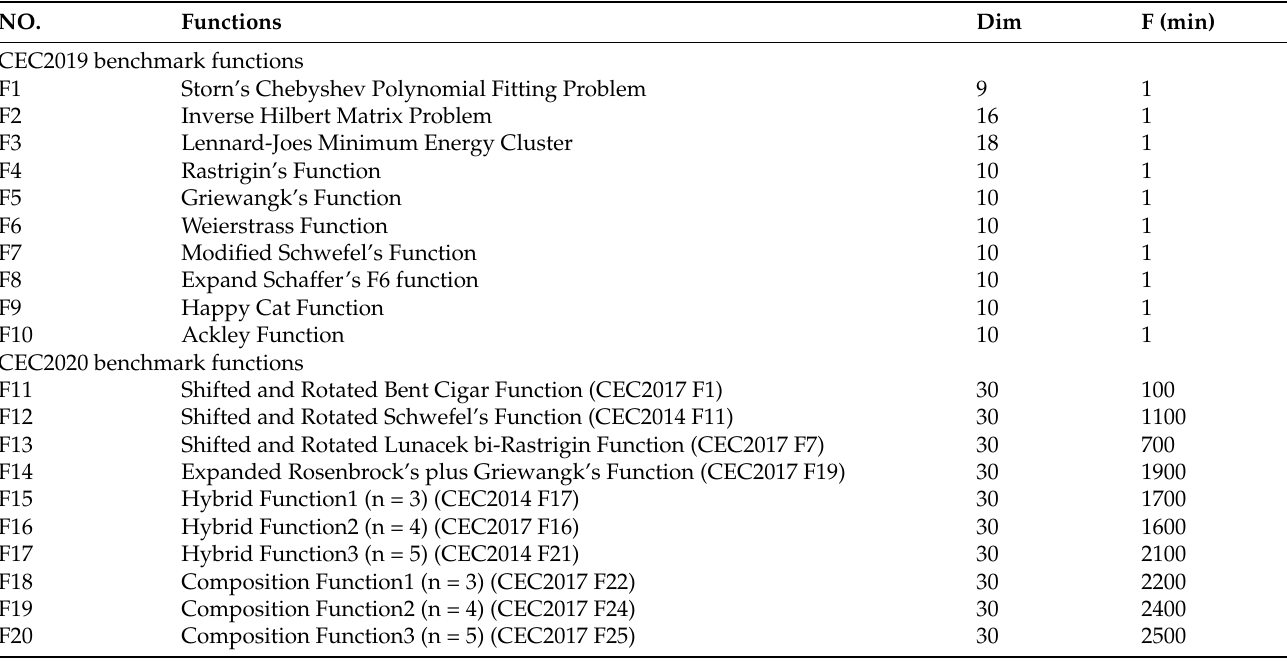
Table A1. Description of the benchmark